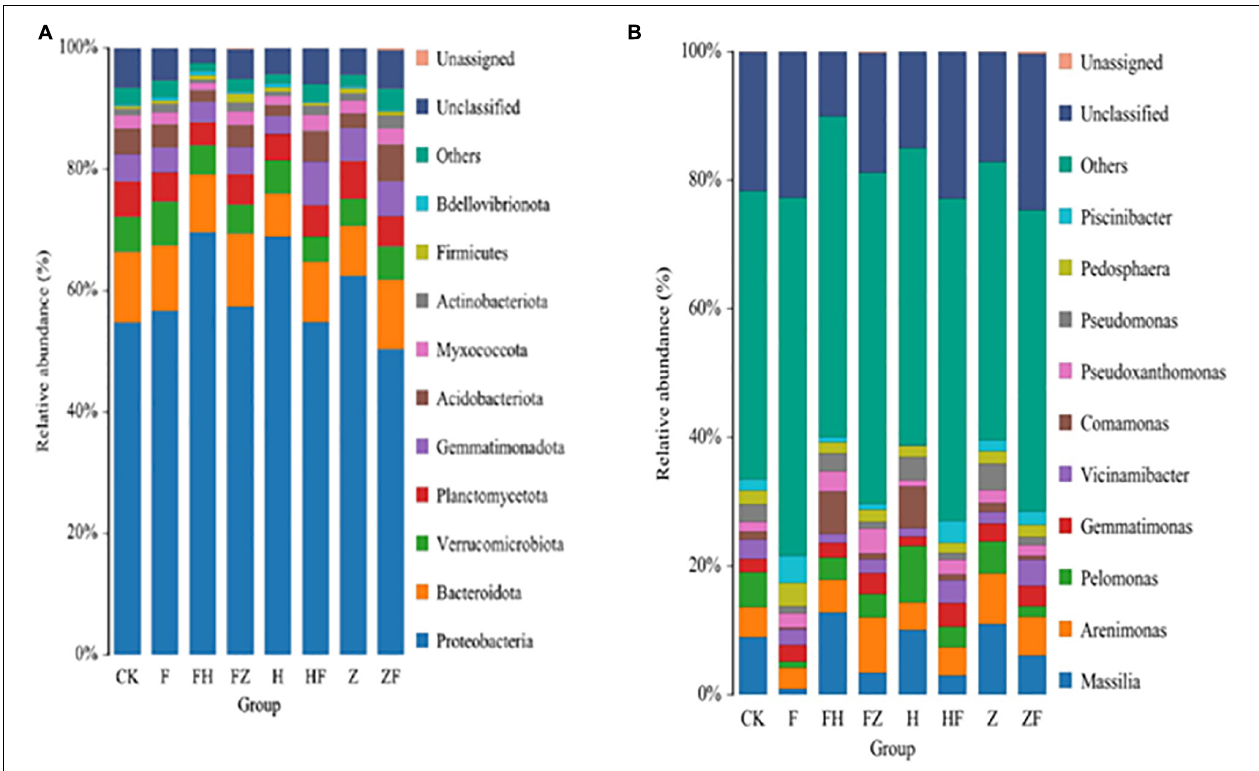
FIGURE 7 | Stacked bar charts showing the relative abundances (in different colors) of the top 10 classified bacterial phyla (A) and genera (B) detected in soil samples subjected to different treatments: CK, control; F, F. oxysporum alone; FH, F. oxysporum + HSB1; FZ, F. oxysporum + FZB42; H, HSB1 alone; HF, HSB1 + F. oxysporum ; Z, FZB42 alone; ZF, FZB42 + F. oxysporum . Relative abundance was based on the proportional frequencies of DNA sequences classified at the phylum and genus levels. Length of a color bar correlates with amount of abundance. Data were averaged from three replicates of each